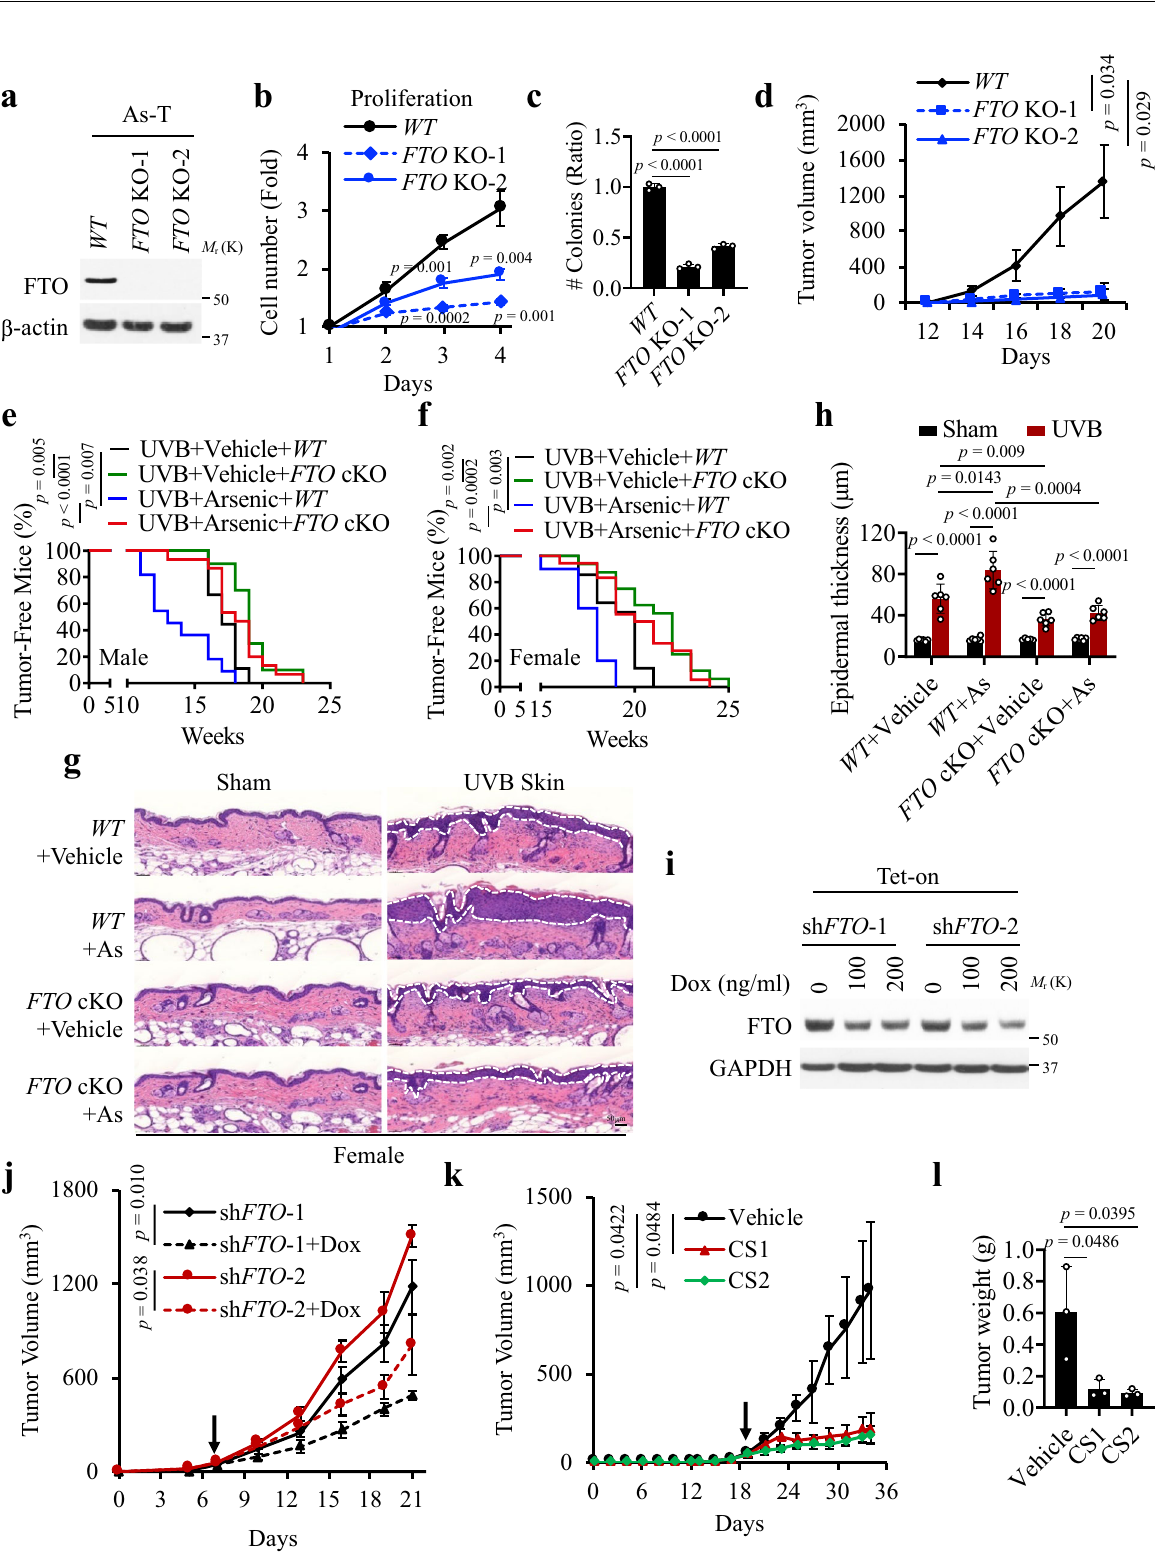
decreased cell growth (Supplementary Fig. 2l), tumor growth (Fig. 2k), and tumor weight (Fig. 2l), supporting the anti-tumor effects of these FTO inhibitors in As-T cells. Overall, these fi ndings demonstrate that FTO is required for arsenic-induced malignant transformation and tumorigenesis and that targeting FTO genetically or pharmacologically inhibits the tumorigenicity of arsenic-treated cells.